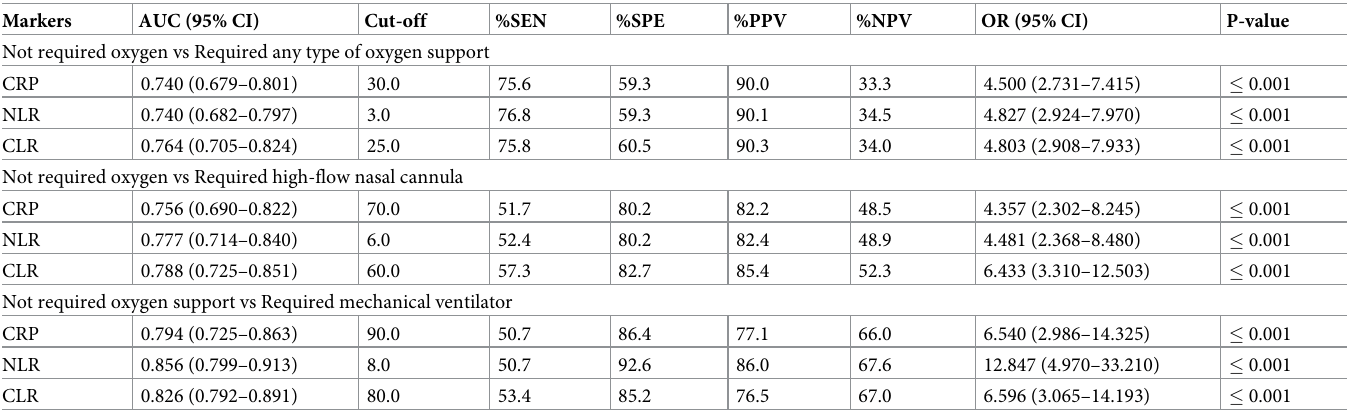
Table 5. Assessment of the inflammatory markers in predicting types of oxygen support management in COVID-19 patients.